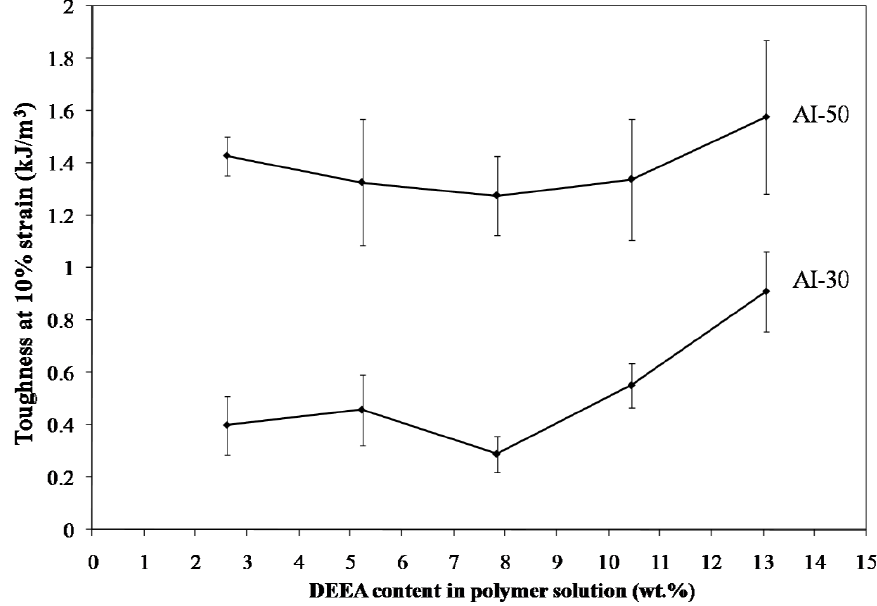
Figure 5. Toughness at 10% strain of 5 wt.% Na + -MMT/2.5 wt.% AI-30 composites as a function of amine concentration.